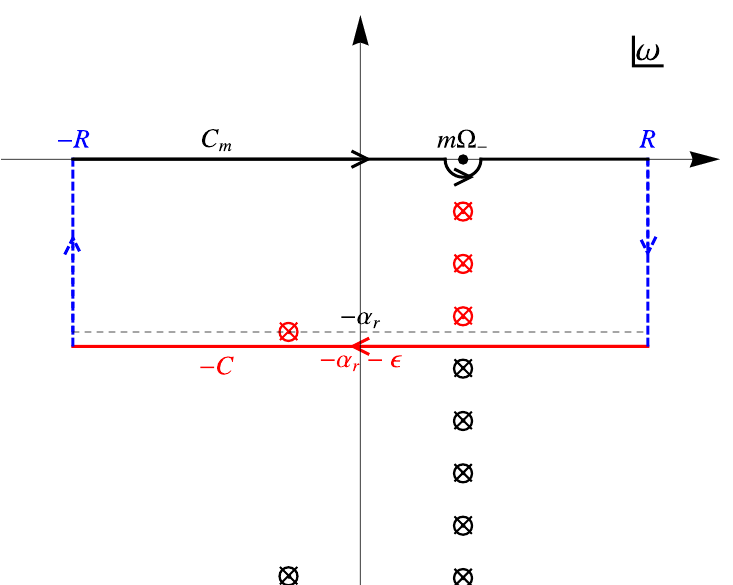
Figure 4 . Contours of integration C and C m in the complex ! plane and the relevant poles: poles marked in red contribute to the integral and poles marked in black don’t. The pole with smallest j Im( ! ) j on the left is the fundamental retrograde quasinormal mode $ m and on the right we show the poles with ! (cid:0) m (cid:10) (cid:0) = (cid:0) in(cid:20) (cid:0) which only give a smooth contribution at CH +